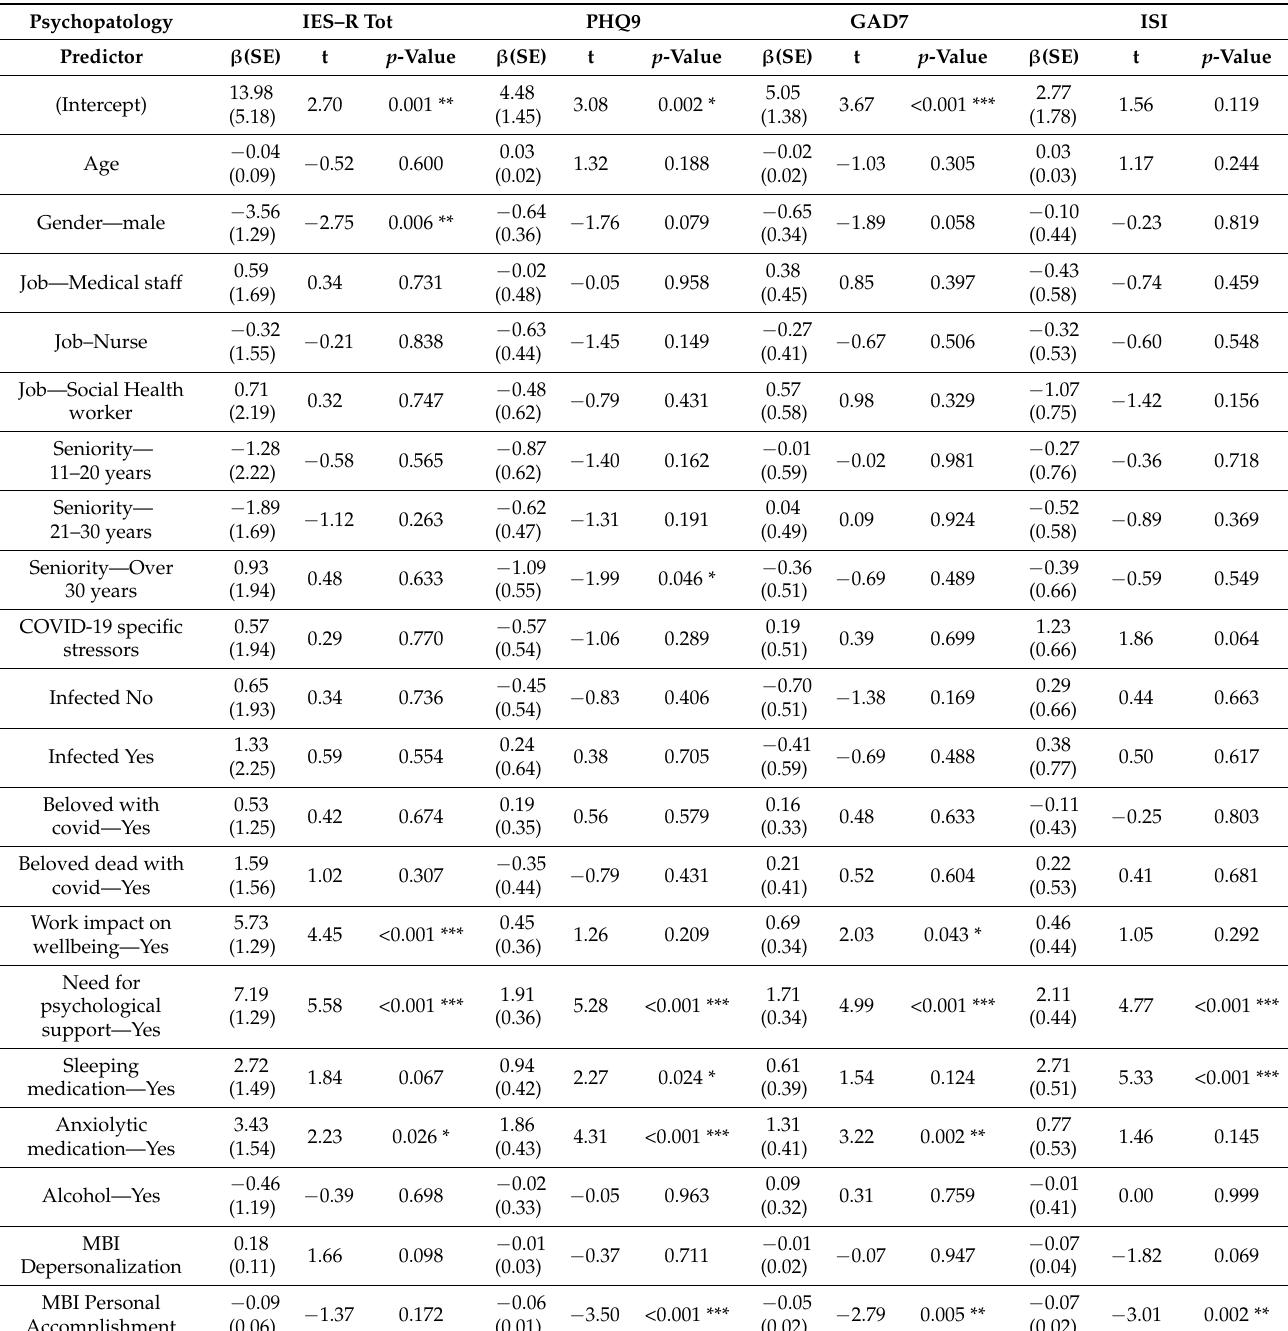
Table 2. Results of Multivariate Multiple